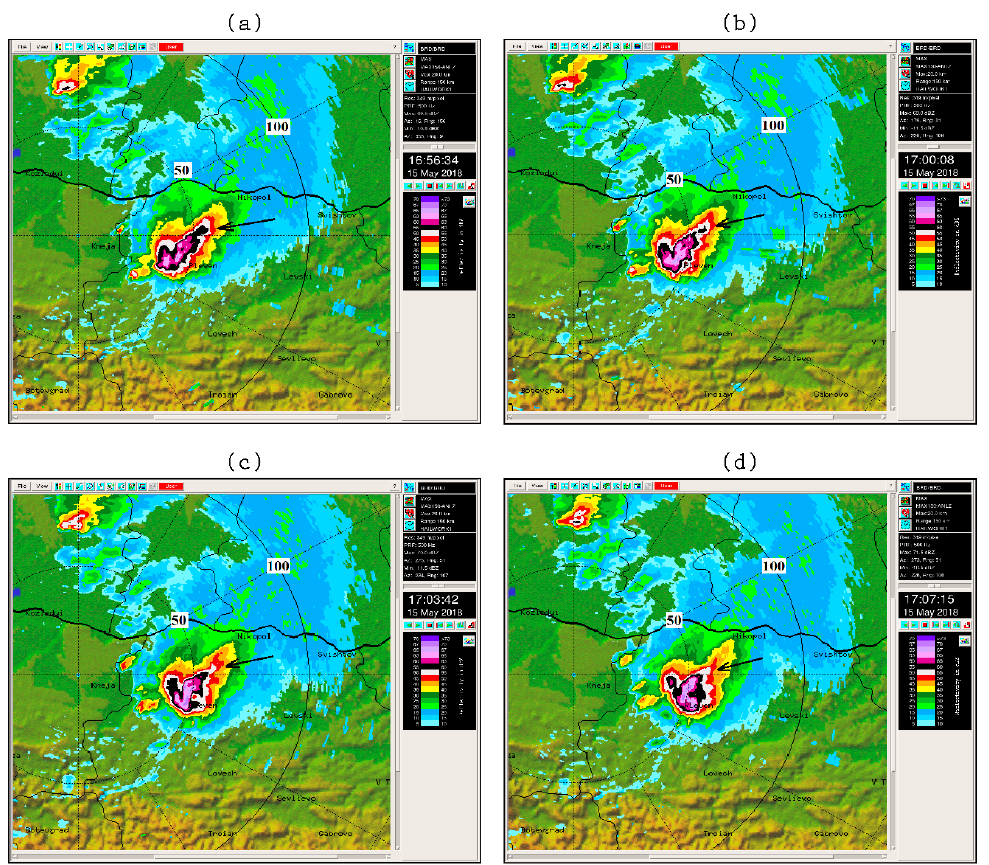
Figure 6. Radar reflectivity images showing the presence of a V-notch signature (black arrow) in the supercell at ( a ) 13:56 UTC, ( b ) 14:00 UTC, ( c ) 14:03 UTC and ( d ) 14:07 UTC. The presence of a V-notch coincided with radar reflectivity of 5 dBZ registered above 17 km ASL and overshooting tops on the visible satellite channels (not shown). In addition, the radar reflectivity factor increased to 68.5 dBZ at 1 km ASL. These high values of the maximum radar reflectivity coincided with large hail (above 2 cm in diameter) reports in the local media. The supercell maintained high reflectivity values whilst moving at a ~60° angle to the right of the mean winds until it began to dissipate near the town of Levski at about 15:30 UTC. 3.2.2. Lightning Activity The development of the supercell was characterized by a substantial increase in total (IC and CG) flash rates (TFR; Figure 7)—a direct result of the updraft’s intensification [17,85]. The first lightning discharge registered in the thunderstorm was IC and occurred at 10:58 UTC when the reflectivity reached 45 dBZ at 5.7 km above sea level (approximately at the level of the − 15 ° С isotherm). During the initial, non-severe stage of the thunderstorm (10:51–11:28 UTC), the TFR was significantly lower in comparison with the severe stages (Figure 7). However, the TFR increased during that time, following several jumps (a TFR jump is defined as a sudden increase in the TFR values, which are at least two times their original values) until 11:28 UTC, when a BWER became visible on the radar. These jumps in the flash rate coincided with an abrupt increase in the heights of the 15 dBZ and 45 dBZ values by 5.4 km and 2.6 km, respectively (Figure 7). The aforementioned heights were both above the − 40 °C isotherm after 11:20 UTC when an overshooting top was observed (not shown). The vertical profile of radar reflectivity indicated that the storm had a strong updraft.